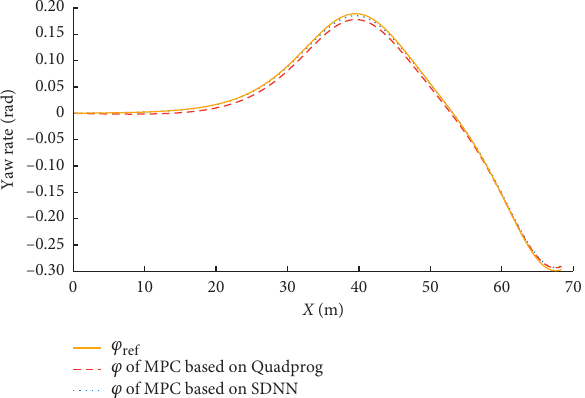
Figure 26: Yaw angles of two